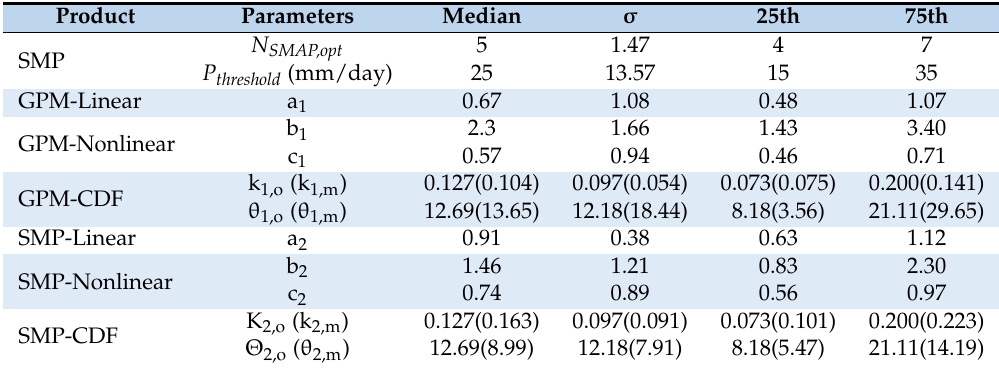
Table 1. Summary statistics of the spatial distribution of the calibrated parameters for the seven correction